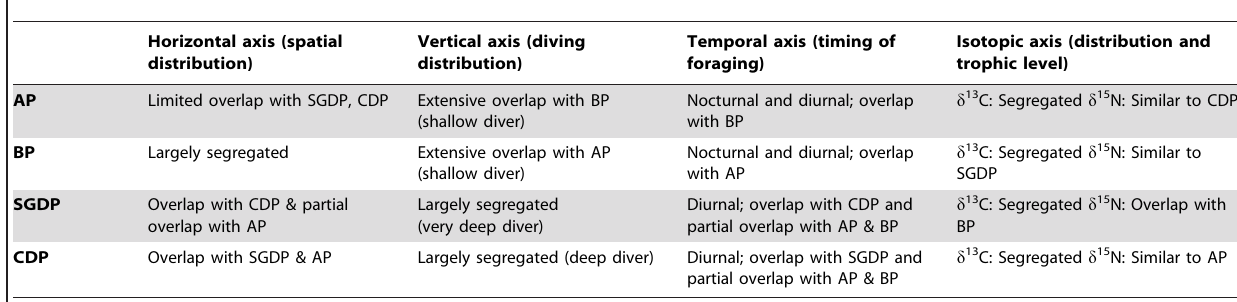
Table 2. Summary of the evidence in the present study for interspecific overlap/segregation in each ecological niche axis between Antarctic prion (AP), blue petrel (BP), common diving petrel (CDP) and South Georgian diving petrel (SGDP).